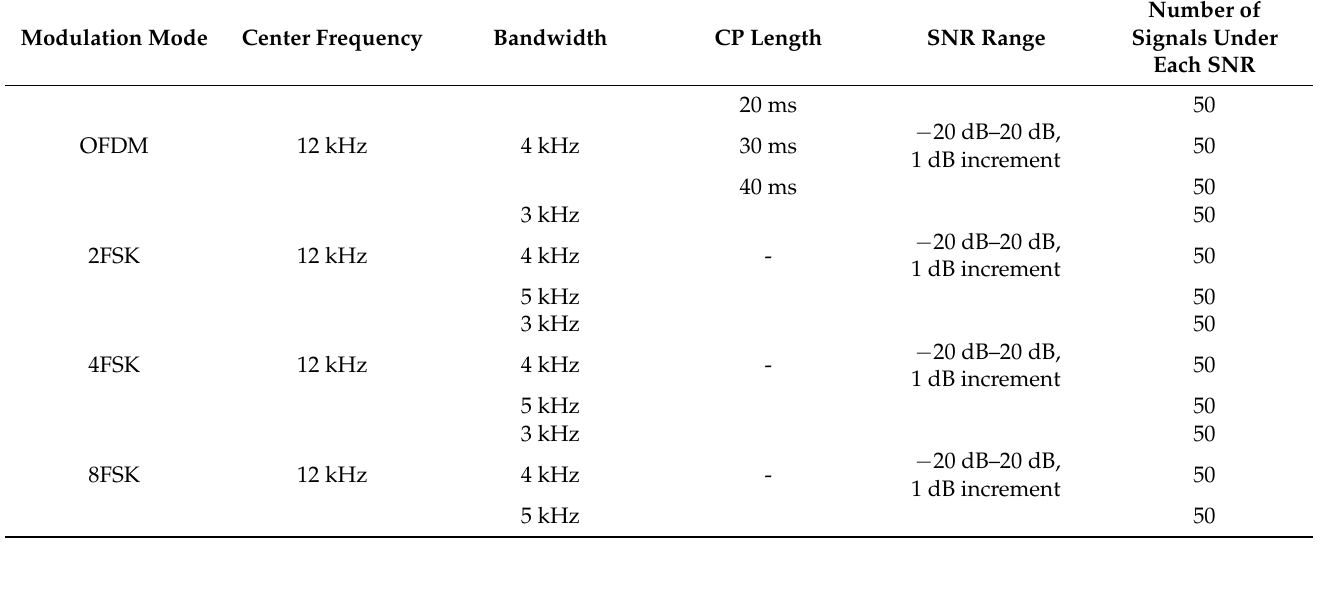
Table 1. Parameter setting of the simulated signals.